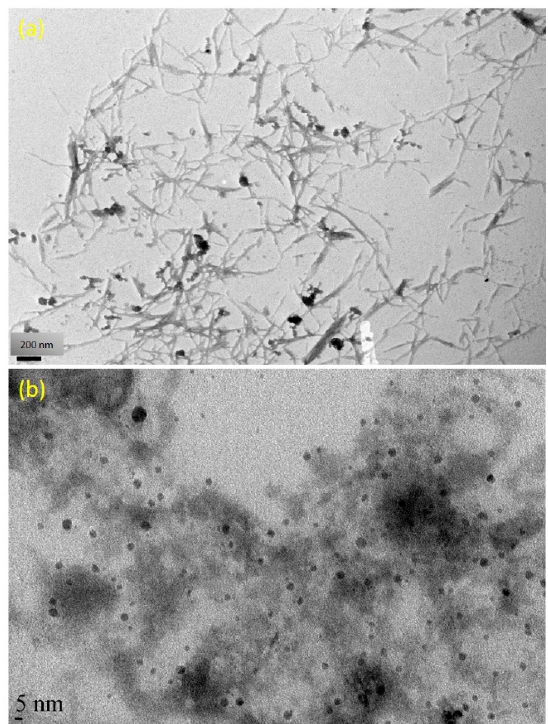
Figure 3. TEM images of ( a ) CNC and ( b ) AgNPs in Ag/Alg samples. Nanomaterials 2019 , 9 , x FOR PEER REVIEW